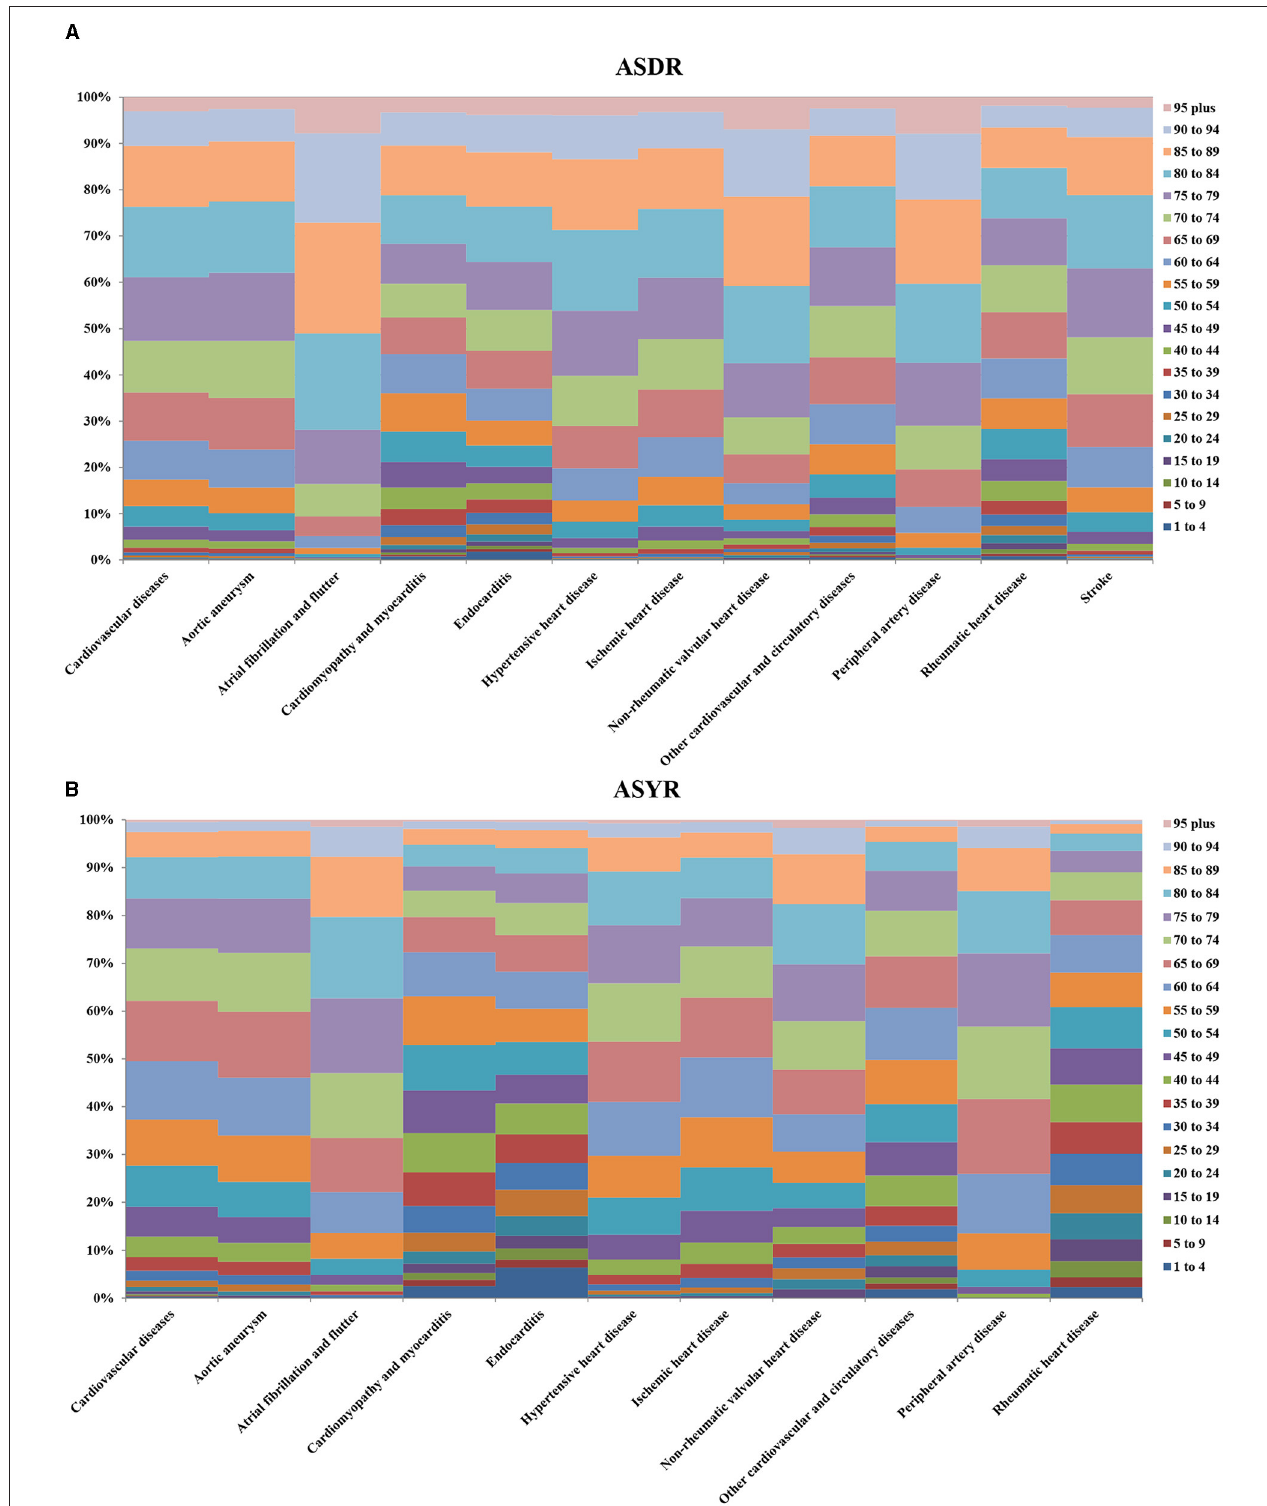
FIGURE 3 | Percentage of global death (A) and DALYs (B) for CVD and its 11 categories in 2017. The left vertical axis means the percentage of global death and DALYs, and the right vertical axis shows different age groups, the lateral axis represents the different cardiovascular diseases.